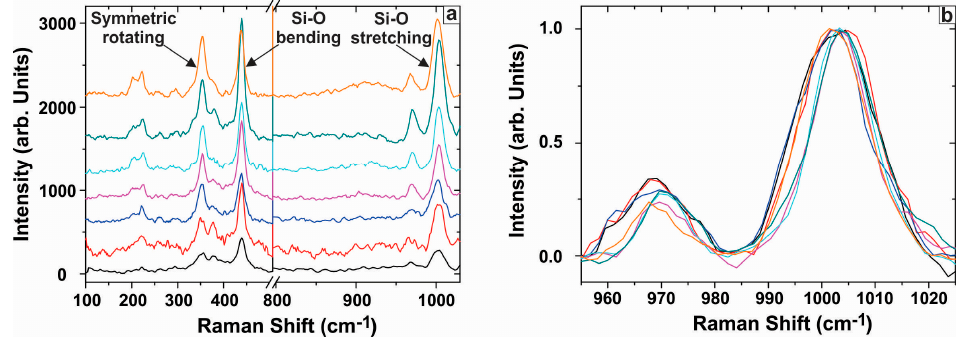
Figure 14. ( a ) Raman spectra in the wavenumber range of 100–1025 cm − 1 for the studied zircons; ( b ) Spectra of zircons normalized to the height of the v 3 (SiO 4 ) stretching mode at ~1008 cm − 1 .